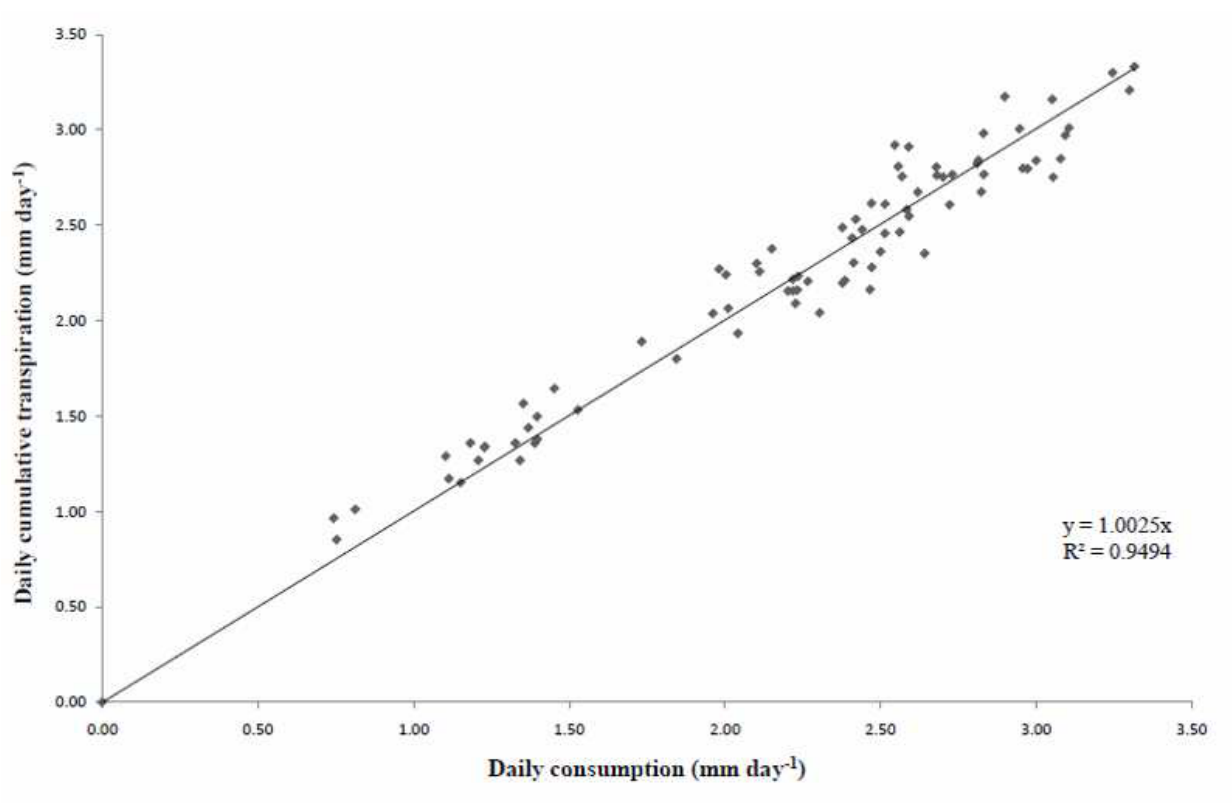
Figure 8. Testing the values of transpiration measured with daily consumption data in a spring-summer cycle. It represents the daily accumulated transpiration and the daily average of the five trays with twelve plants consumption